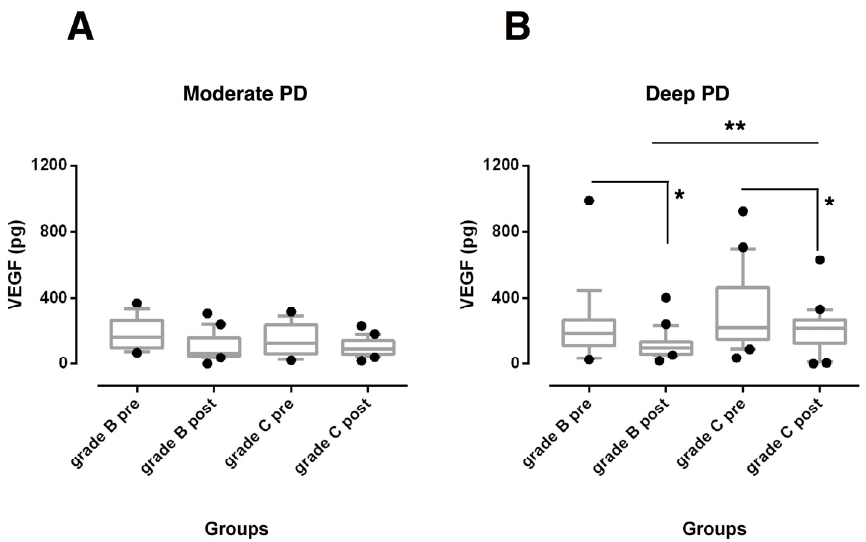
Figure 3. Box-and-whisker plots showing the total amount of vascular endothelial growth factor (VEGF) in gingival crevicular fluid of moderate ( A ) and deep pocket sites ( B ) in subjects with grade B and grade C stage III periodontitis before (pre) and after non-surgical periodontal therapy (post). Horizontal line represents the median with the box representing the 25th and 75th percentiles, and the whiskers denote the 5th and 95th percentiles. * p < 0.05, ** p < 0.01.